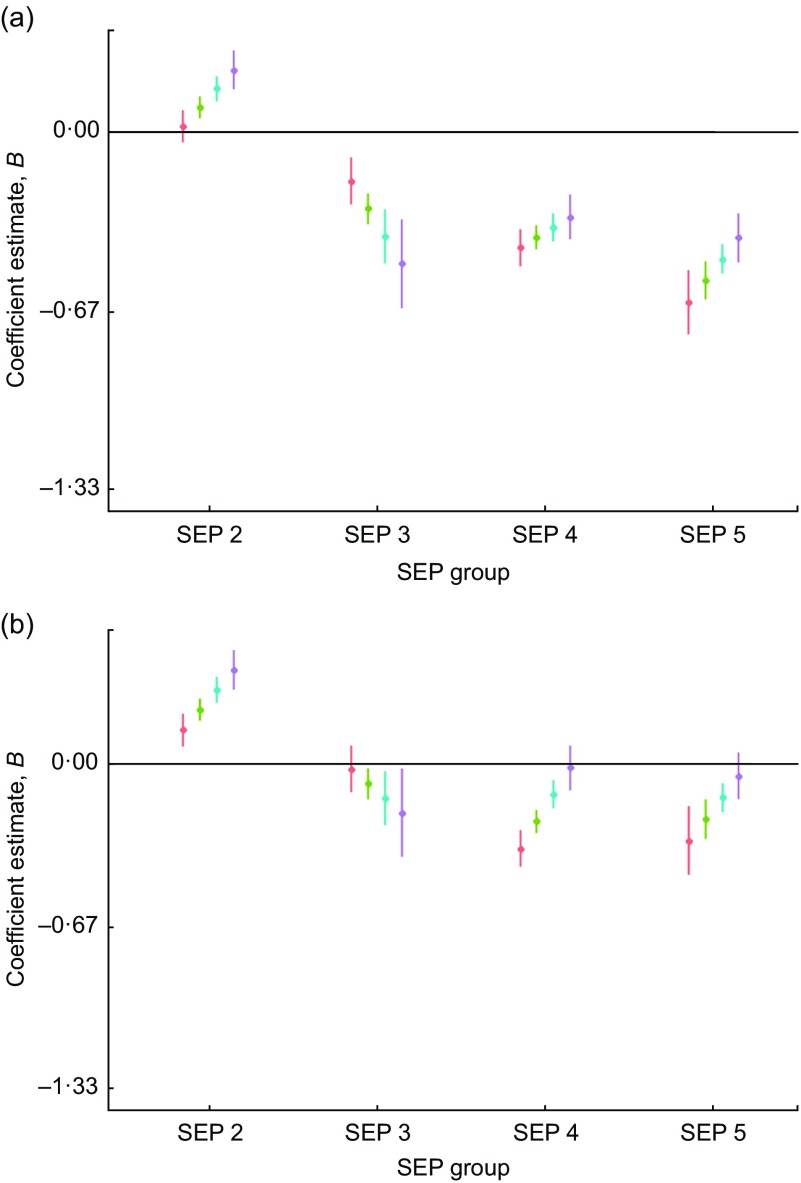
Regression estimates of (a) male and (b) female BMI size Z-scores (dots) with 95 % CI (whiskers) across socio-economic position (SEP) groups (2–5), with SEP 1 as reference group (horizontal line at 0), by decade of birth centred on 1960 (), 1970 (), 1980 () and 1990 (), for children and adolescents (n 40 484) aged 3–19 years of Ladino and Maya ancestry born during 1955–1993 in Guatemala (n
observations 157 067). The plots were created using R packages ggplot2, broom, jtools, dotwhisker and dplyr (see the online supplementary material for references)